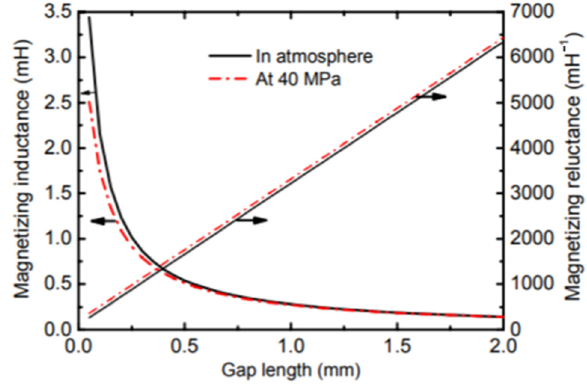
Figure 19. Gap length effect on EM coupler.